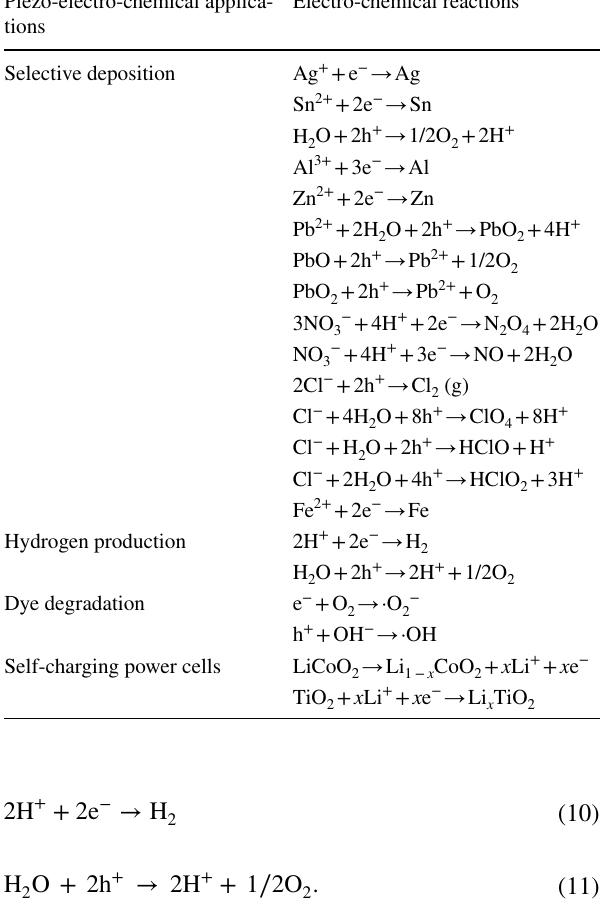
Electro‑chemical